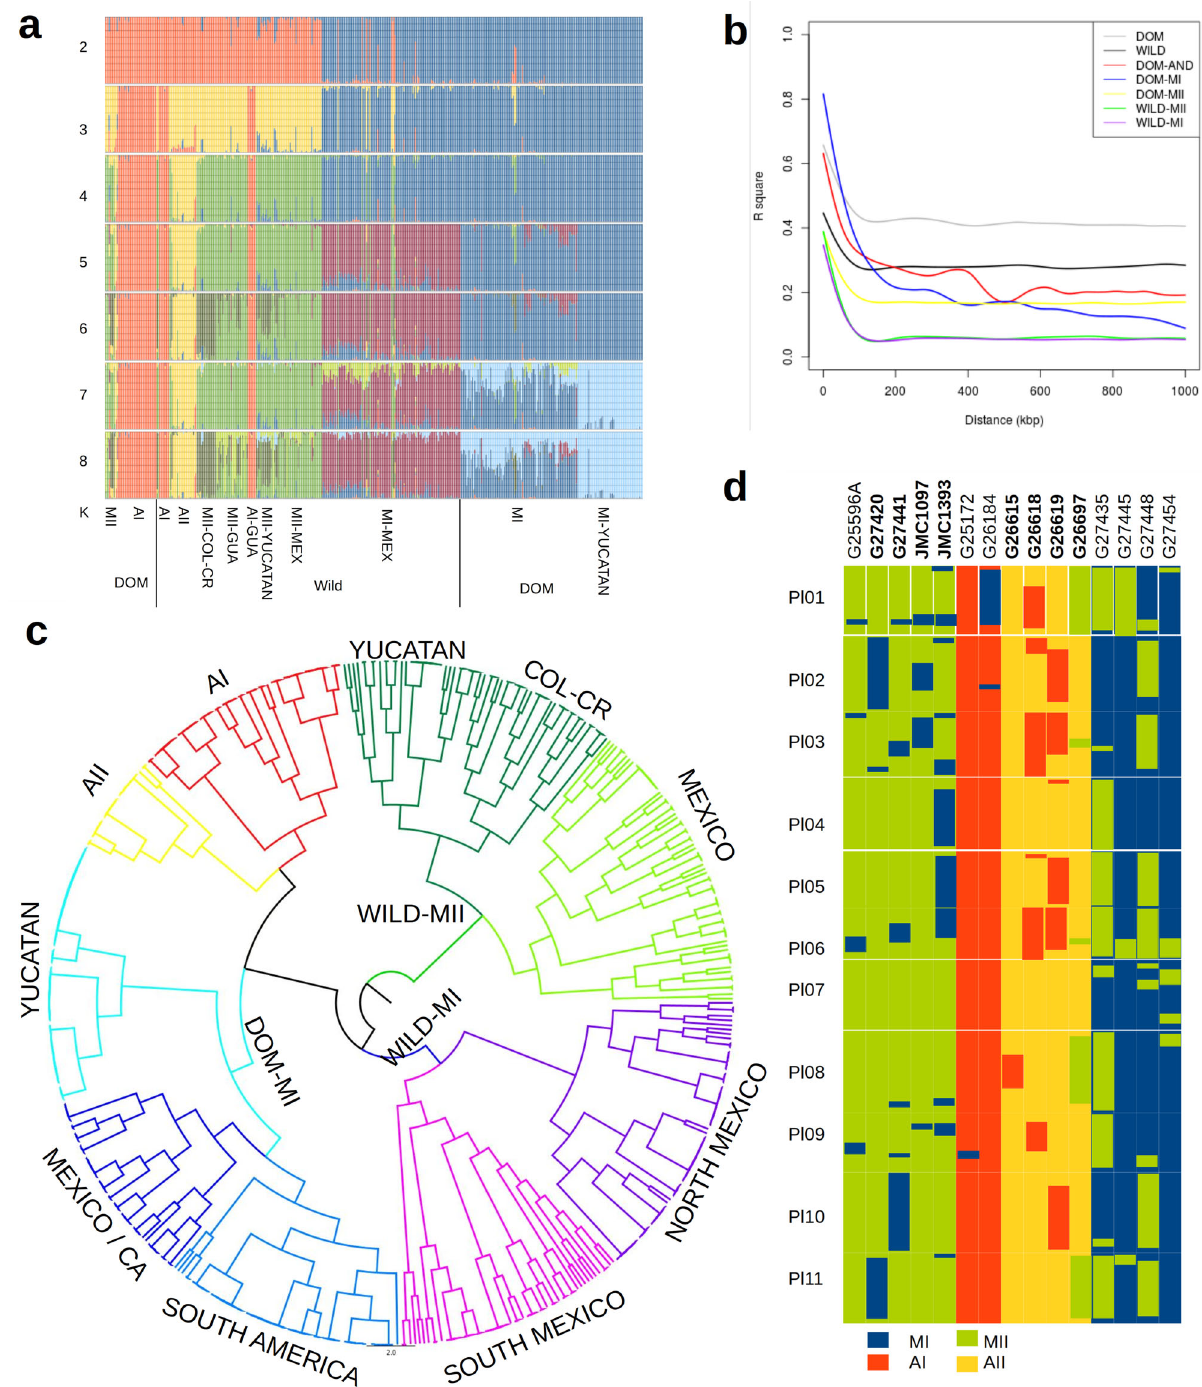
Fig. 3 Lima bean genetic diversity. a STRUCTURE analysis of the genetic variability between 482 wild and domesticated Lima bean accessions collected across the Americas. Wild accessions are organized (from left to right) into a south-north geographic pattern. DOM domesticated, MEX Mexico, GUA Guatemala, CR Costa Rica, COL Colombia. Classi fi cation of accessions into gene pools MI, MII, AI, or AI is shown. b Linkage disequilibrium decay within different subgroups of wild and domesticated accessions. DOM domesticated, DOM-AND Andean landraces. c Radial clustering of the 482 accessions according to the analysis performed by fi neSTRUCTURE. Major gene pools are shown by different colors (purple cluster: wild MI from northern-western Mexico (NORTH MEXICO); pink cluster: wild MI from southern-western Mexico (SOUTH MEXICO); medium blue cluster: domesticated MI from South America; dark blue cluster: domesticated MI from Mexico and Central America (MEXICO/CA); light blue cluster: domesticated MI from Yucatan Peninsula; yellow cluster: AII gene pool; red cluster: AI gene pool; green cluster: MII gene pool from Yucatan, Central America, and Colombia (YUCATAN COL-CR); light green cluster: MII gene pool from southern and central Mexico. d Distribution of chromosomal segments contributed by different gene pools in a set of 15 wild and domesticated accessions. Wild accessions are marked in bold. Lima bean chromosomes are labeled as Pl01-Pl11. Source data are provided as a Source Data fi